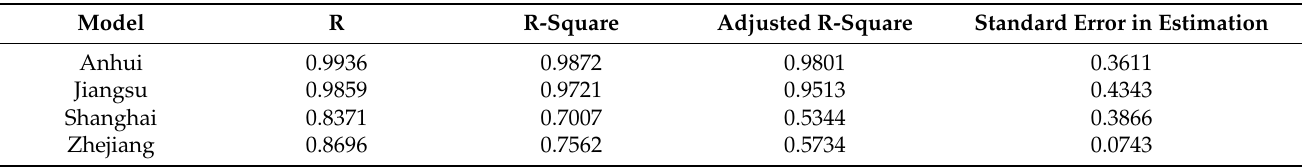
Table 4. Table Models Summary.